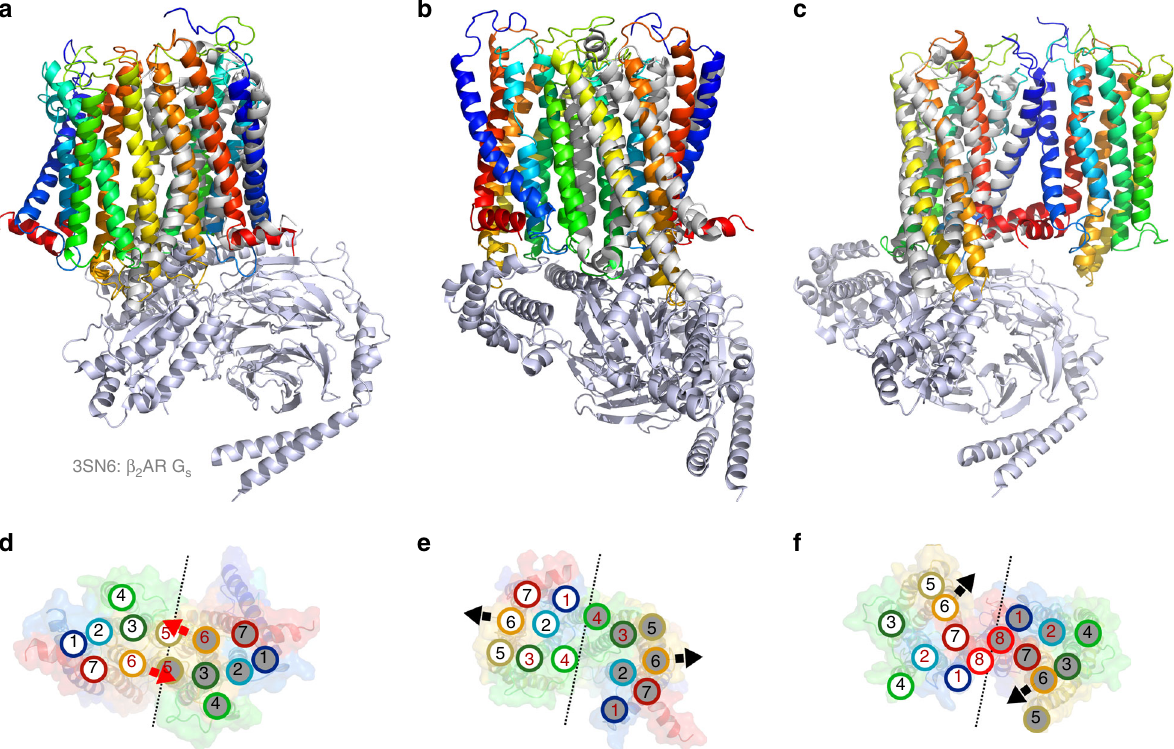
Fig. 6 Alignment of G protein-bound receptor structure to MD dimer models The crystal structure of the active-state β 2 -adrenergic receptor in complex with the heterotrimeric G s protein (grey; PDB 3SN6, T4 lysozyme and nanobody are omitted here) 41 aligned to the a TM5-6, b TM3-4, and c TM1 – 2 – H8 dimer interface models of NTS1 is shown here with schematic representations of the intracellular view of each model in panels d – f , respectively. Outward movement of TM5 and 6 in the active receptor would likely result in clashes between the two protomers of the TM5 – 6 interface dimer ( a , d ), but not for the other dimer